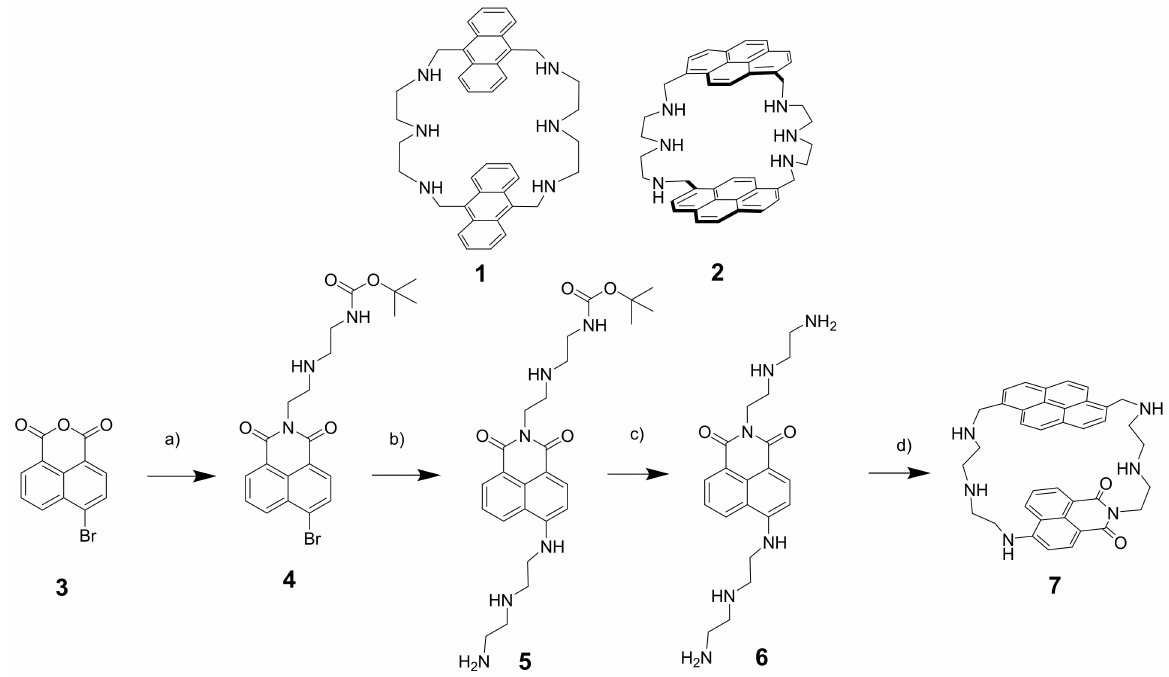
Figure 1. Aza-cyclophanes 1 and 2 previously studied for nucleotide binding and sensing. Synthetic route to receptor 7 : ( a ) mono-BOC-diethylenetriamine, 70 ◦ C, reflux in EtOH (90%); ( b ) diethylenetriamine, toluene, reflux (57%); ( c ) CH 2 Cl 2 - trifluoroacetic acid, r.t. (quant.); ( d ) Pyrene-1,6-dicarbaldehyde, CH 3 OH, 50 ◦ C; NaBH 4